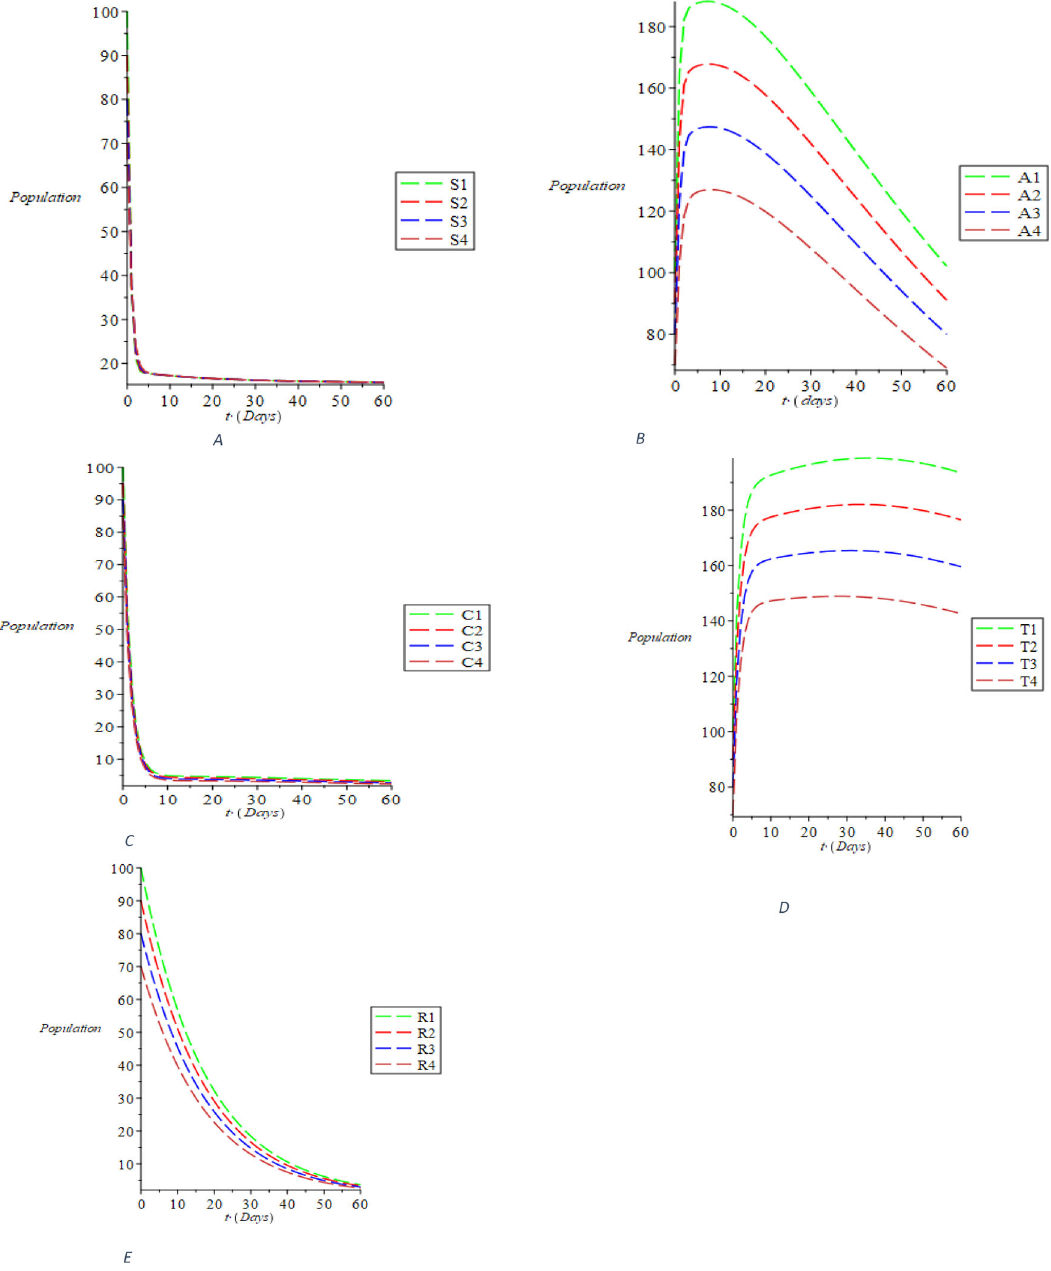
Figure 2. The dynamical behavior of the varying population of the classes: (A) susceptible (B) acute (C) chronic (D) treated (E) recovered using the Maple 19